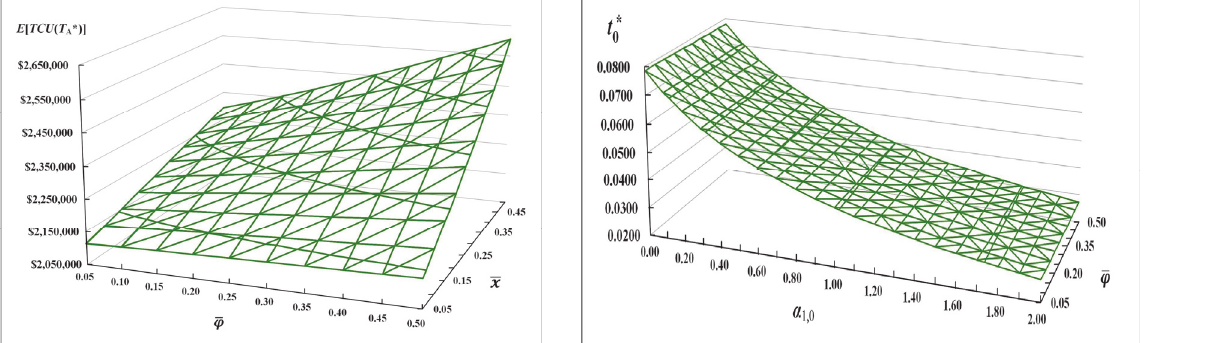
Fig. 12. The collective impact of differences in overtime factor and average scrap rate on t 0